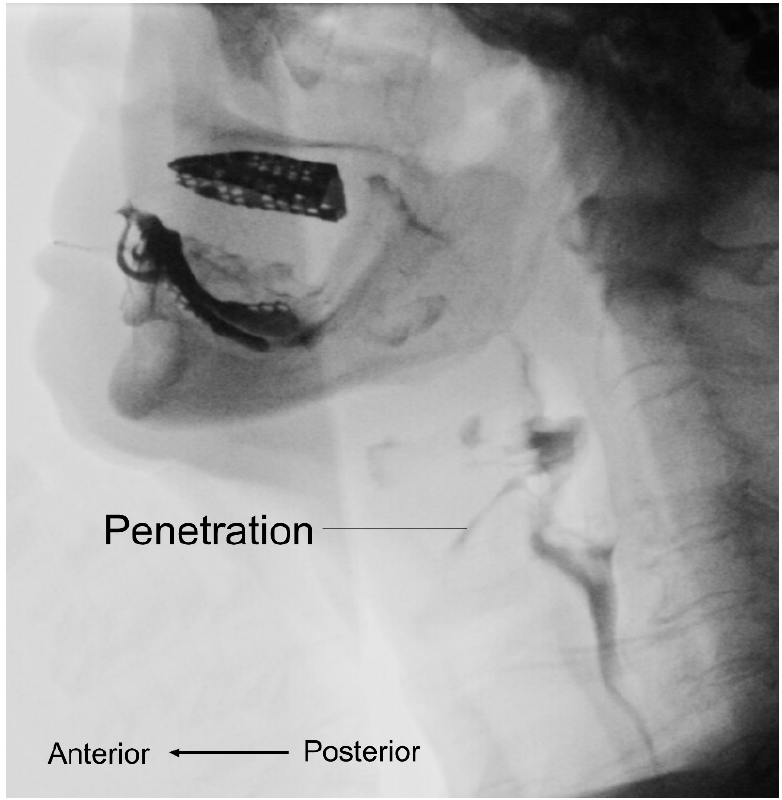
Figure 3. Videofluoroscopic swallow study shows abnormalities during the bolus transport such as penetration. as